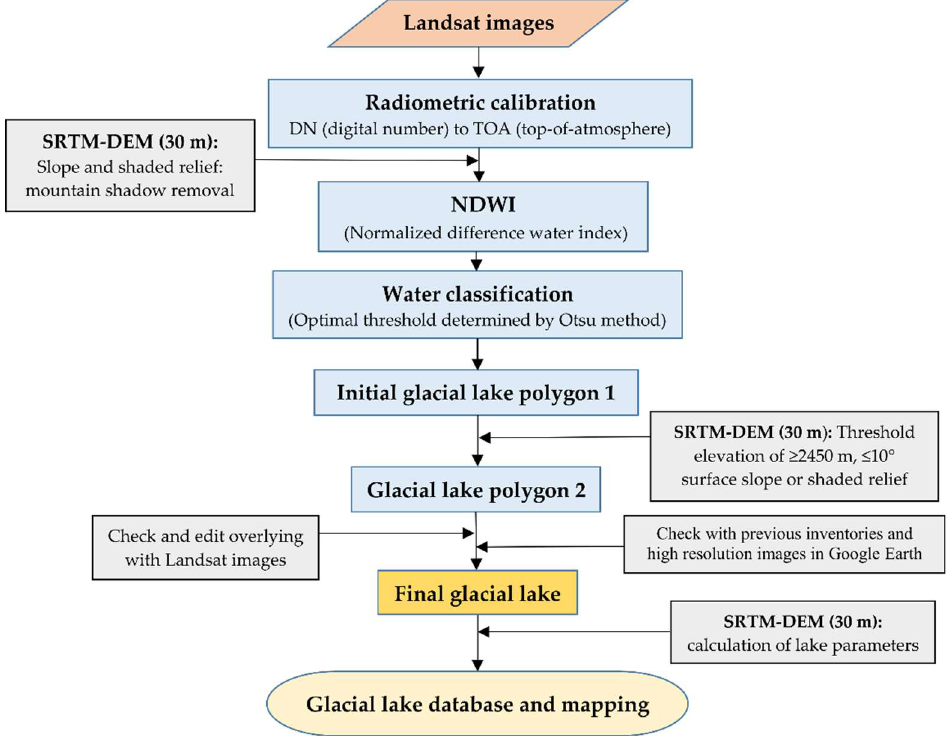
Figure 2. Flowchart of the processes for the glacial lake mapping.